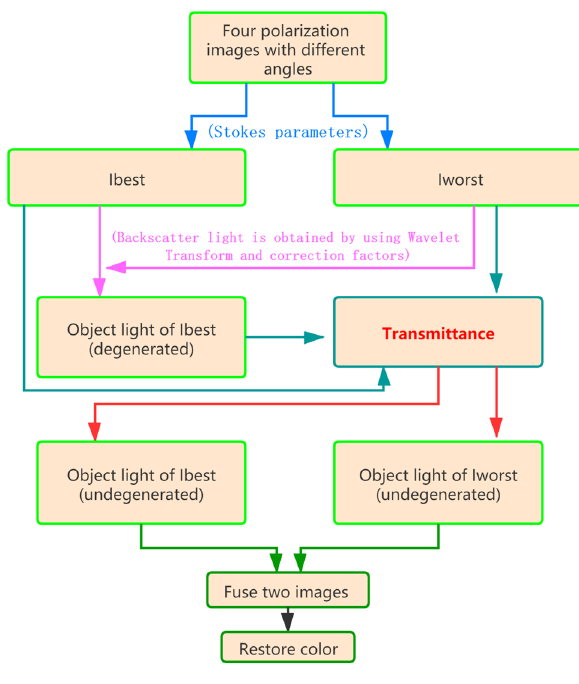
Figure 1. The process of the method proposed in this article.